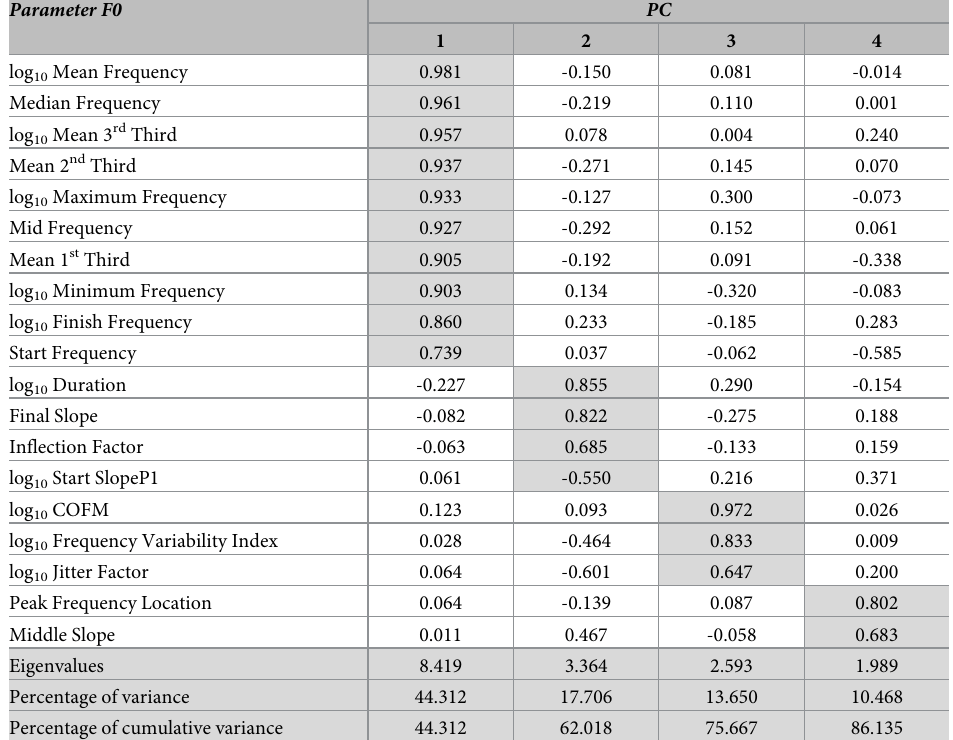
Table 5. Results of the PCA. Conducted with varimax rotation and Kaiser normalization performed on a set of 120 trumpets from 6 individuals (20 per individual).